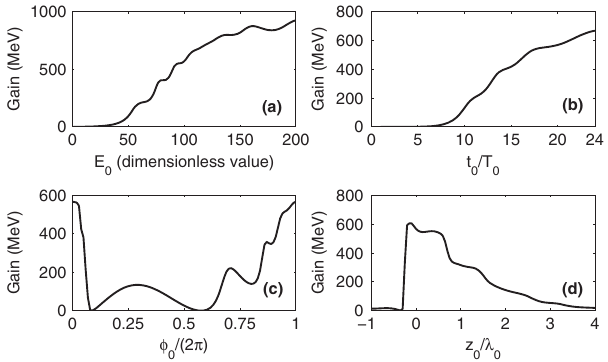
FIG. 6. Energy gain of a test single proton as a function of the peak laser amplitude E phase of the laser field (cid:6) Other parameters are the same as in Fig.